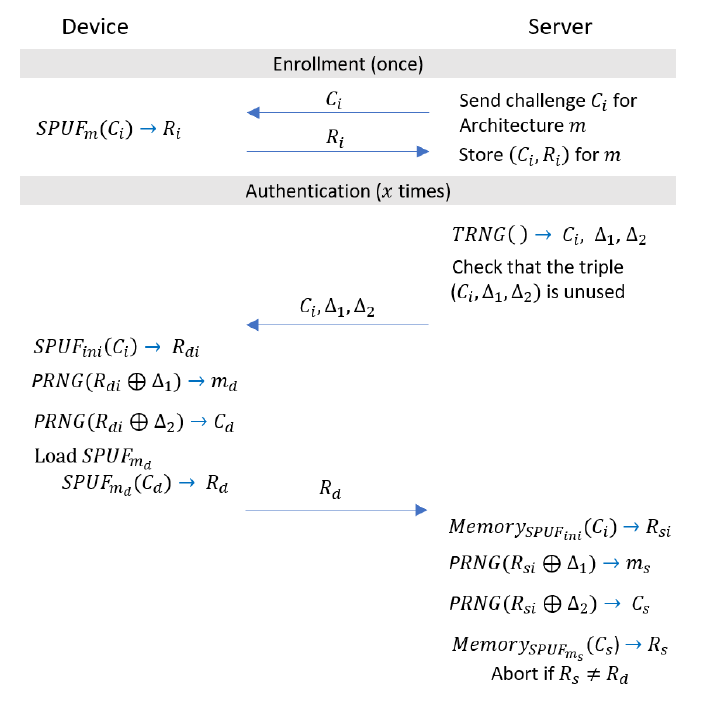
Figure 7. Our RESA-PC authentication protocol, which hides the PUF architecture m and challenge C i , which is used for